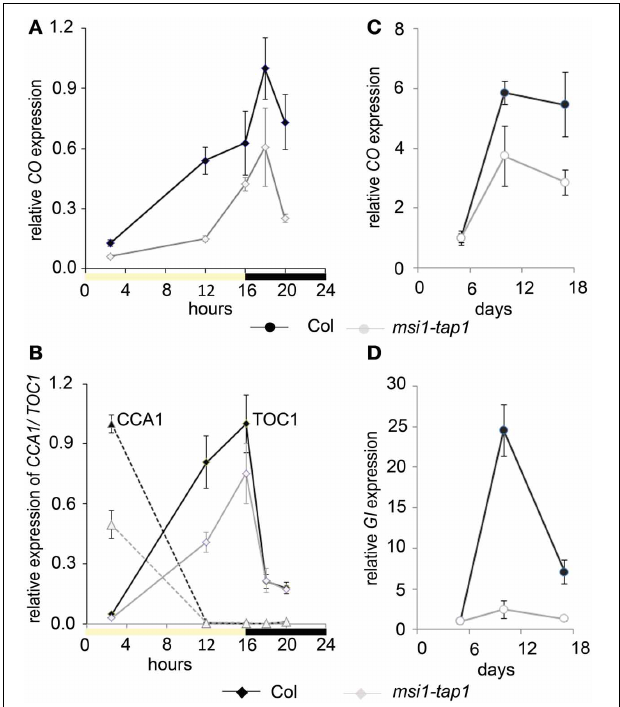
FIGURE 3 | Gene expression of CO and GI is changed in msi1-tap1 in LD. Diurnal gene expression of CO (A) and CCA1 and TOC1 (B) in 10-day-old seedlings in LD. X-axis represents hours after start of the light period (yellow box—light period, black box—dark period). Black lines, Col; gray lines, msi1-tap1 . (C,D) Gene expression kinetics of CO (C) and GI (D) in msi1-tap1 at EOD at 5, 10, and 17 DAGs. Values are relative expression ± SE ( n = 3).